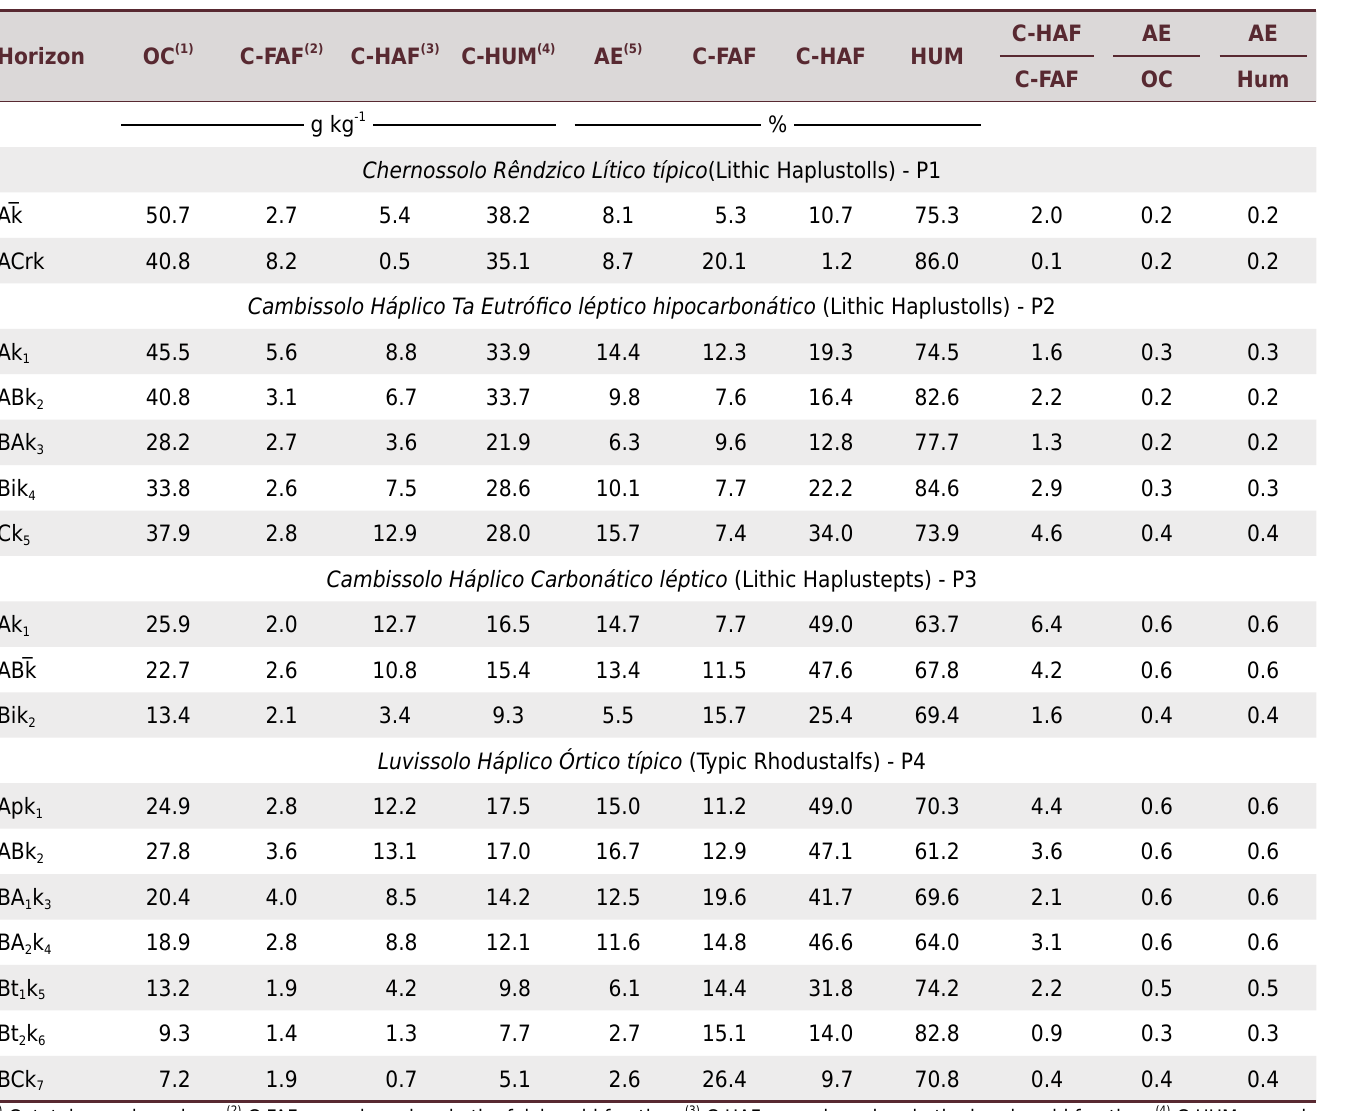
Table 5. Chemical fractioning of organic matter of soils in a toposequence in Lavandeira, TO,